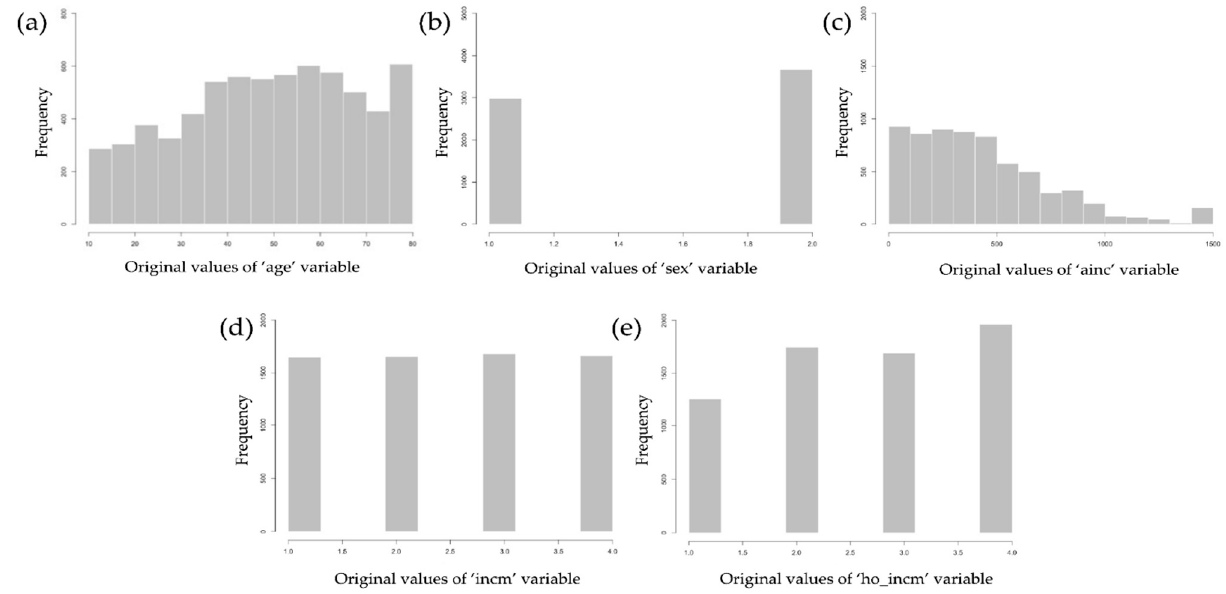
Figure 2. Distributions of variables used in our study: ( a ) distribution of “age”, ( b ) distribution of “sex”, ( c ) distribution of “ainc”, ( d ) distribution of “incm”, and ( e ) distribution of “ho_incm”. After verifying the distribution of each variable in the datasets, the remaining varia- bles in the datasets from 1998 to 2019 were compared. For the comparison, common vari- ables were selected from a total of 13 datasets for the years 2007 to 2019. Datasets from 1998 to 2006, with uncommon variables, were excluded. The dimensions and number of participants for the 13 datasets from 2007 to 2019 are listed in Table 3. Table 3. Dimensions and number of participants for datasets from 2007 to